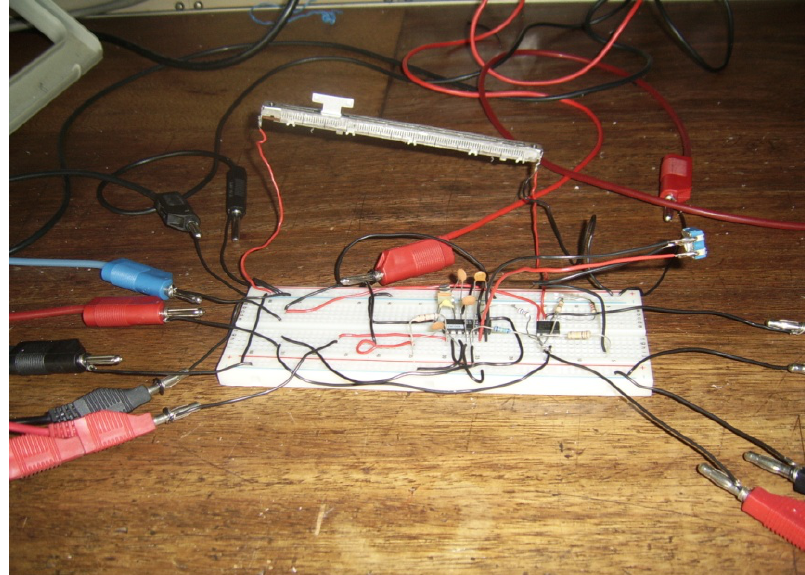
Figure 7. Experimental setup of transducer.